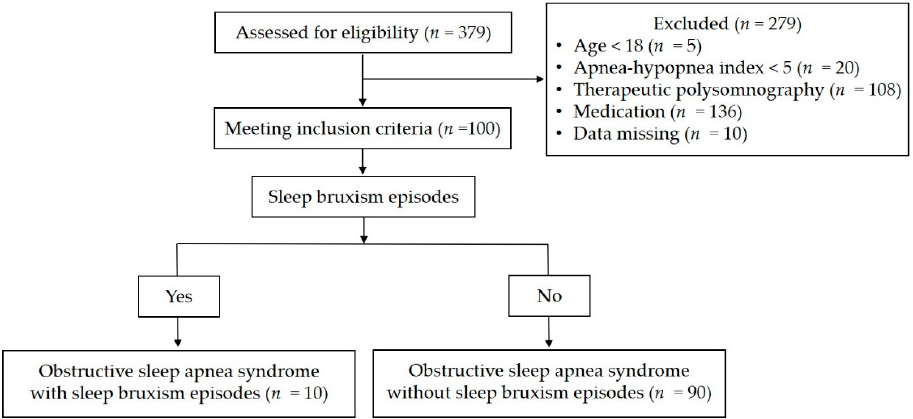
Figure 1. Study flow diagram.